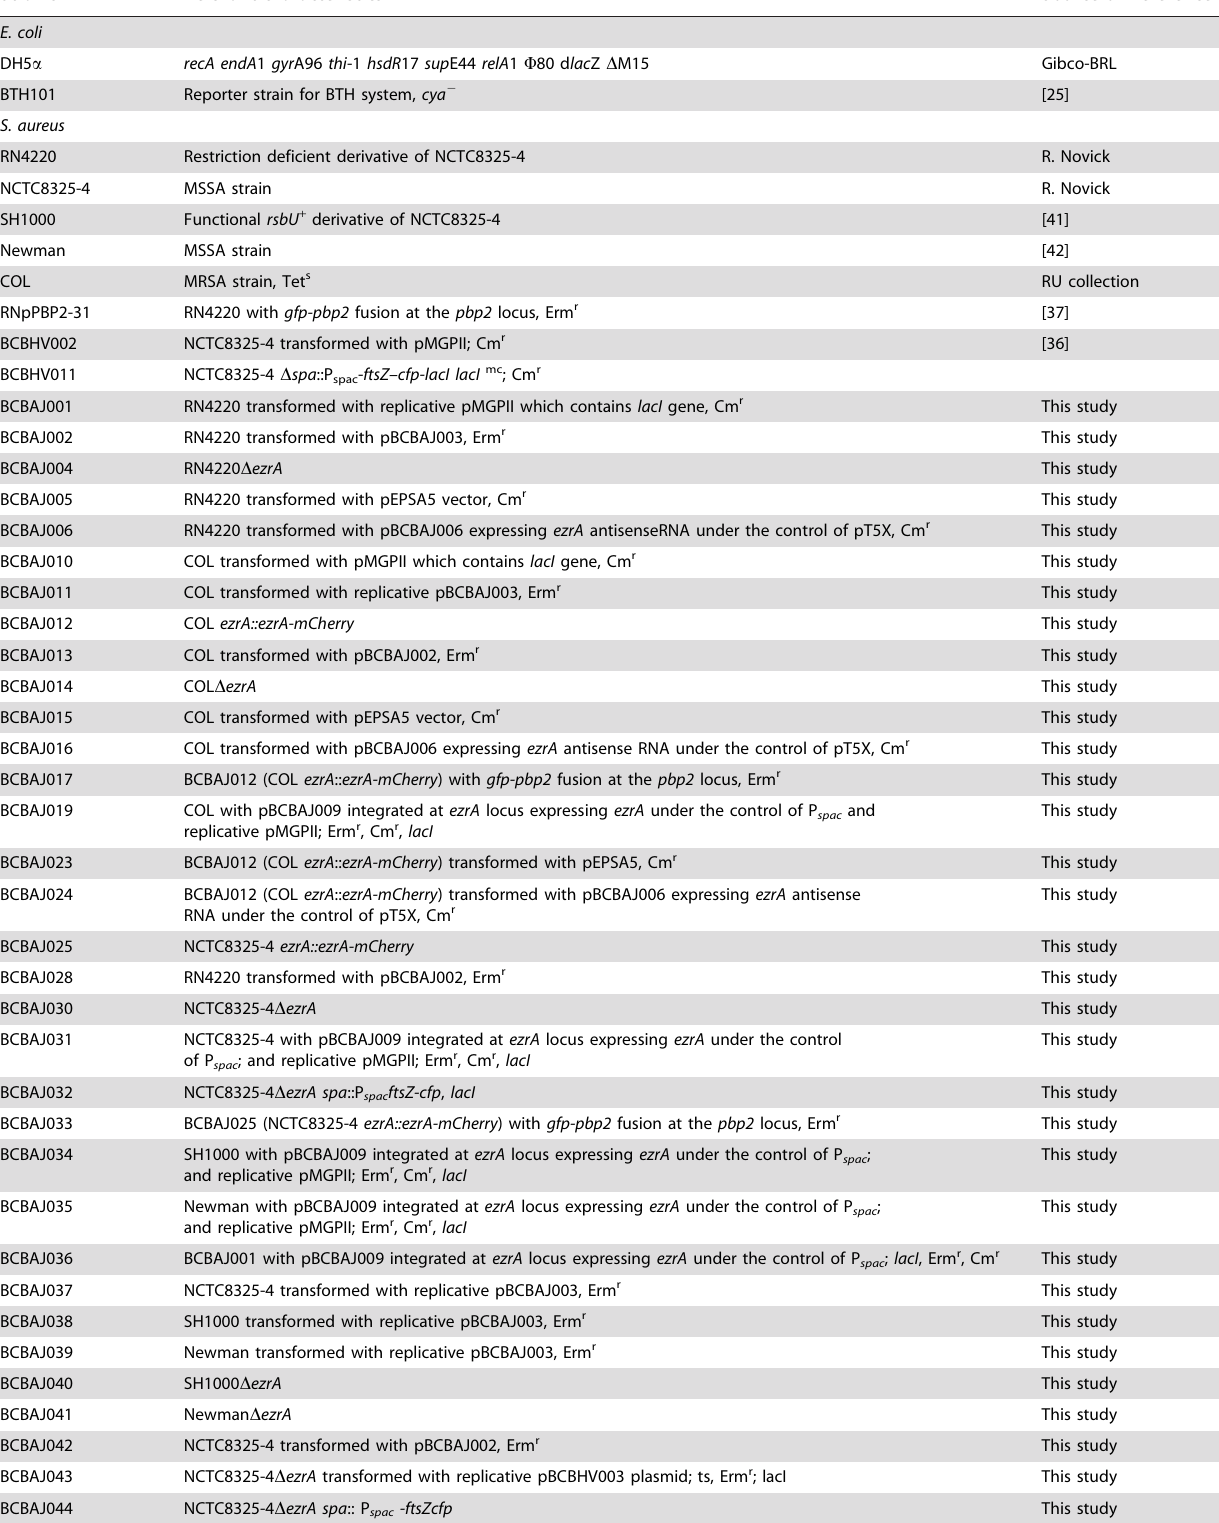
Strains Relevant characteristics Source or